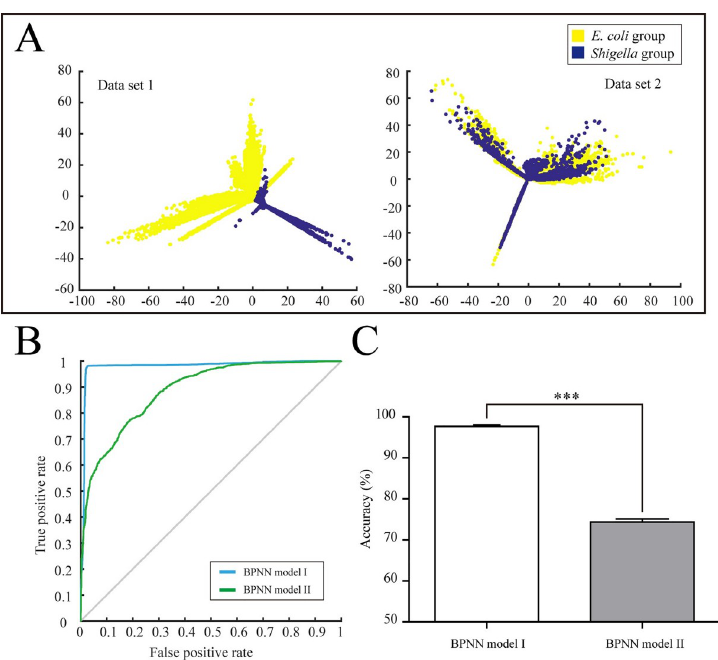
Fig 3. Results of the bacterial identification using artificial neural networks. (A) Scatter-plot of data set 1 and 2 after dimensionality reduction with the isomap algorithm. (B) Receiver operating characteristic curves of the BPNN model I and II were plotted based on the matching extent between the predicted value and the label value. (C) The accuracy was calculated by model simulation using random test samples. The values are the mean ± SD; ��� , p < 0.001 compared with the BPNN model II group, n = 5 independent runs. BPNN, back propagation neural network.